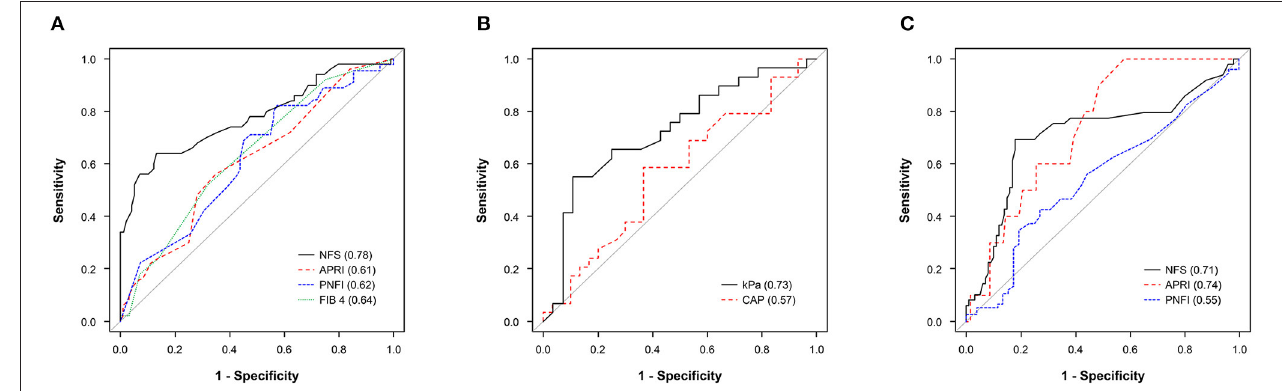
FIGURE 1 | (A) ROC curve of NFS, APRI, PNFI, and FIB-4 in predicting the presence of T2DM. (B) ROC curve of kPa and CAP in predicting the presence of T2DM. (C) ROC curve of HbA1c (%) in predicting any fibrosis progression from NFS (intermediate to high probability fibrosis vs. low probability of fibrosis), APRI (advanced fibrosis to cirrhosis vs. no to indeterminate), and PNFI (fibrosis vs. non-fibrosis). APRI, AST: platelet ratio index; CAP, controlled attenuation parameter; FIB-4, Fibrosis-4 index; HbA1c, hemoglobin A1c; NAFLD, non-alcoholic fatty liver disease; NFS, NAFLD fibrosis score; OR, odds ratio; PNFI, pediatric NAFLD fibrosis index; ROC, receiver operating characteristic; T2DM, type 2 diabetes mellitus.